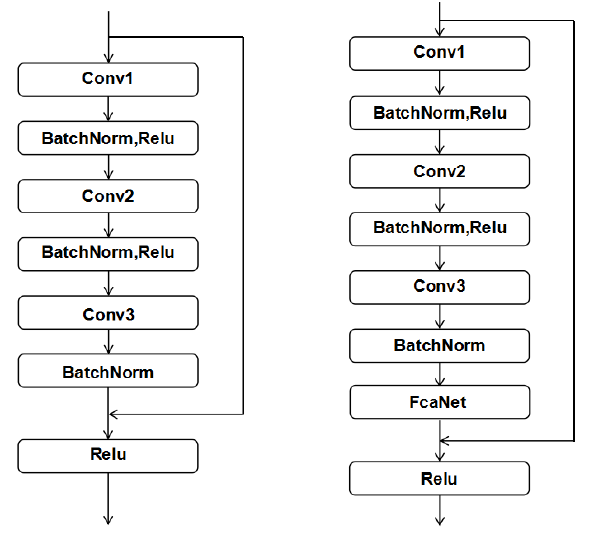
Figure 8. The Bottleneck and